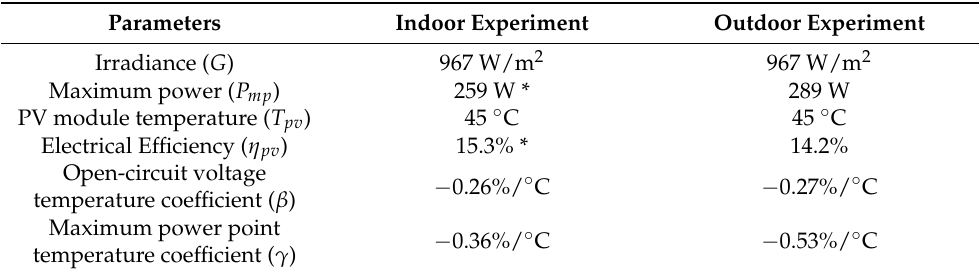
Table 8. Indoor and outdoor electrical characterization